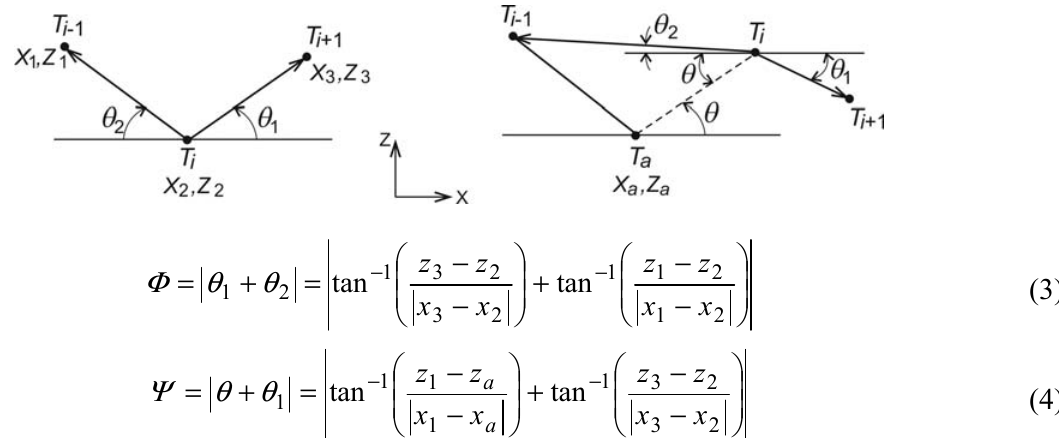
Figure 7. Principle of point data reduction based on straightness